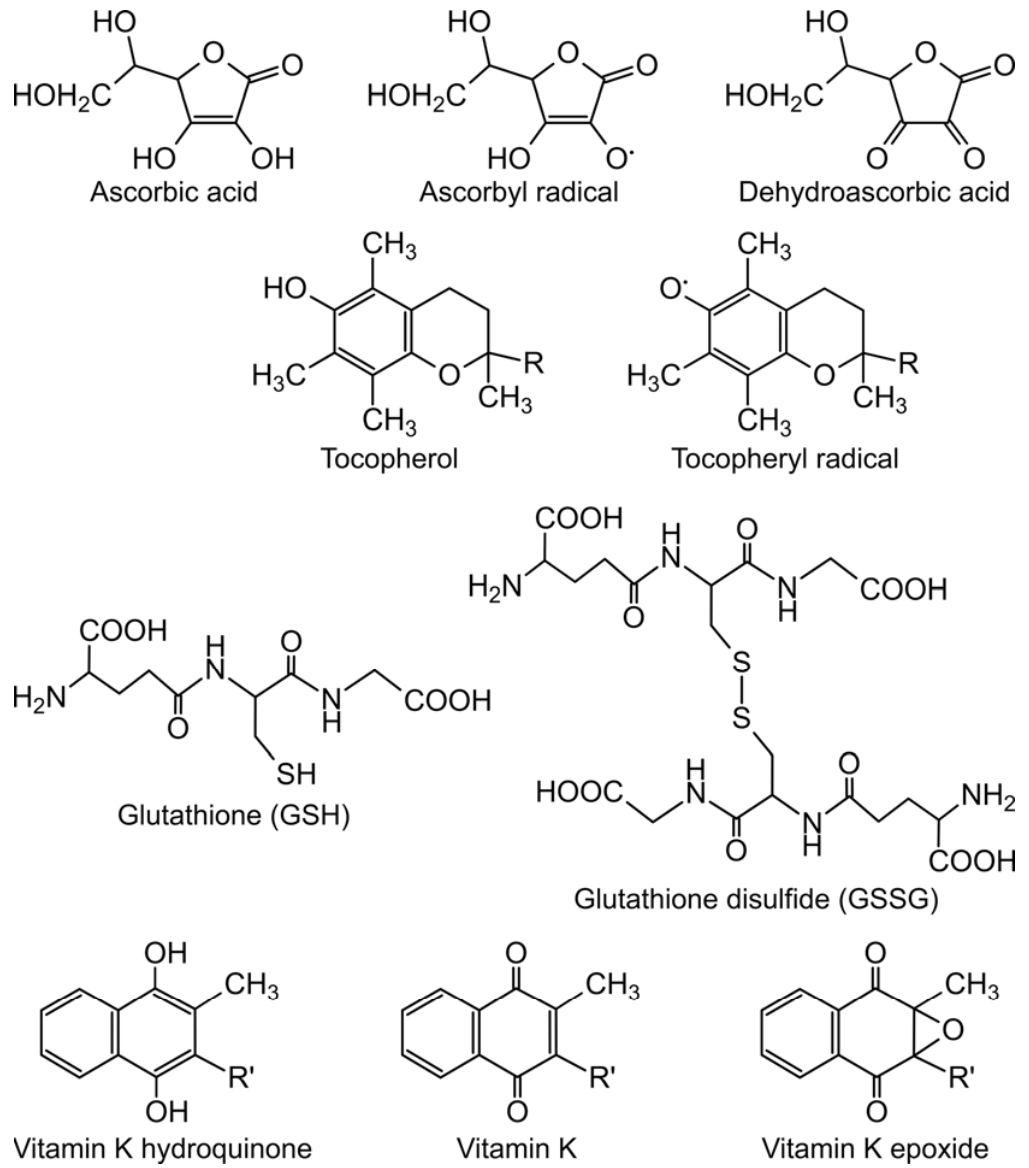
Figure 1. The chemical structure of small-molecule catalysts of oxidative protein